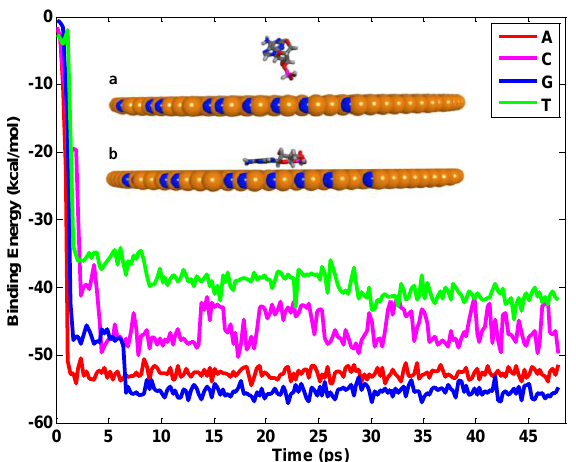
Figure 2. Evolution of binding energy between hBN and four basic nucleotides.